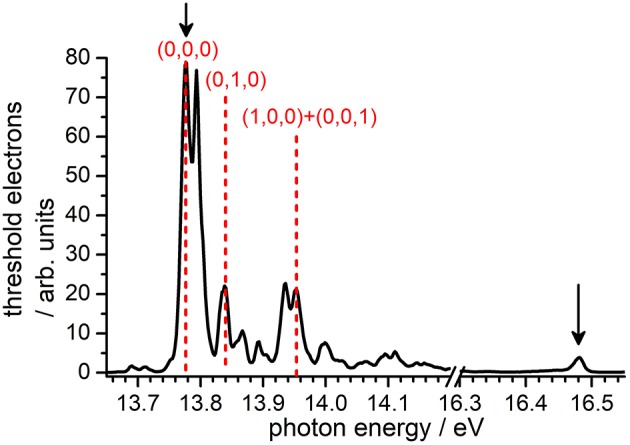
TPEPICO spectrum of CO2 recorded using the CERISES set-up at the DESIRS beamline of the SOLEIL synchrotron. Black solid arrows indicate the photon energies (Ephot) at which reactivity studies in the DC mode have been performed, while red dashed lines indicate the energies chosen for experiments in the coincidence mode, i.e., with selective internal excitation of the CO2+ cation (see section Results and Discussion).